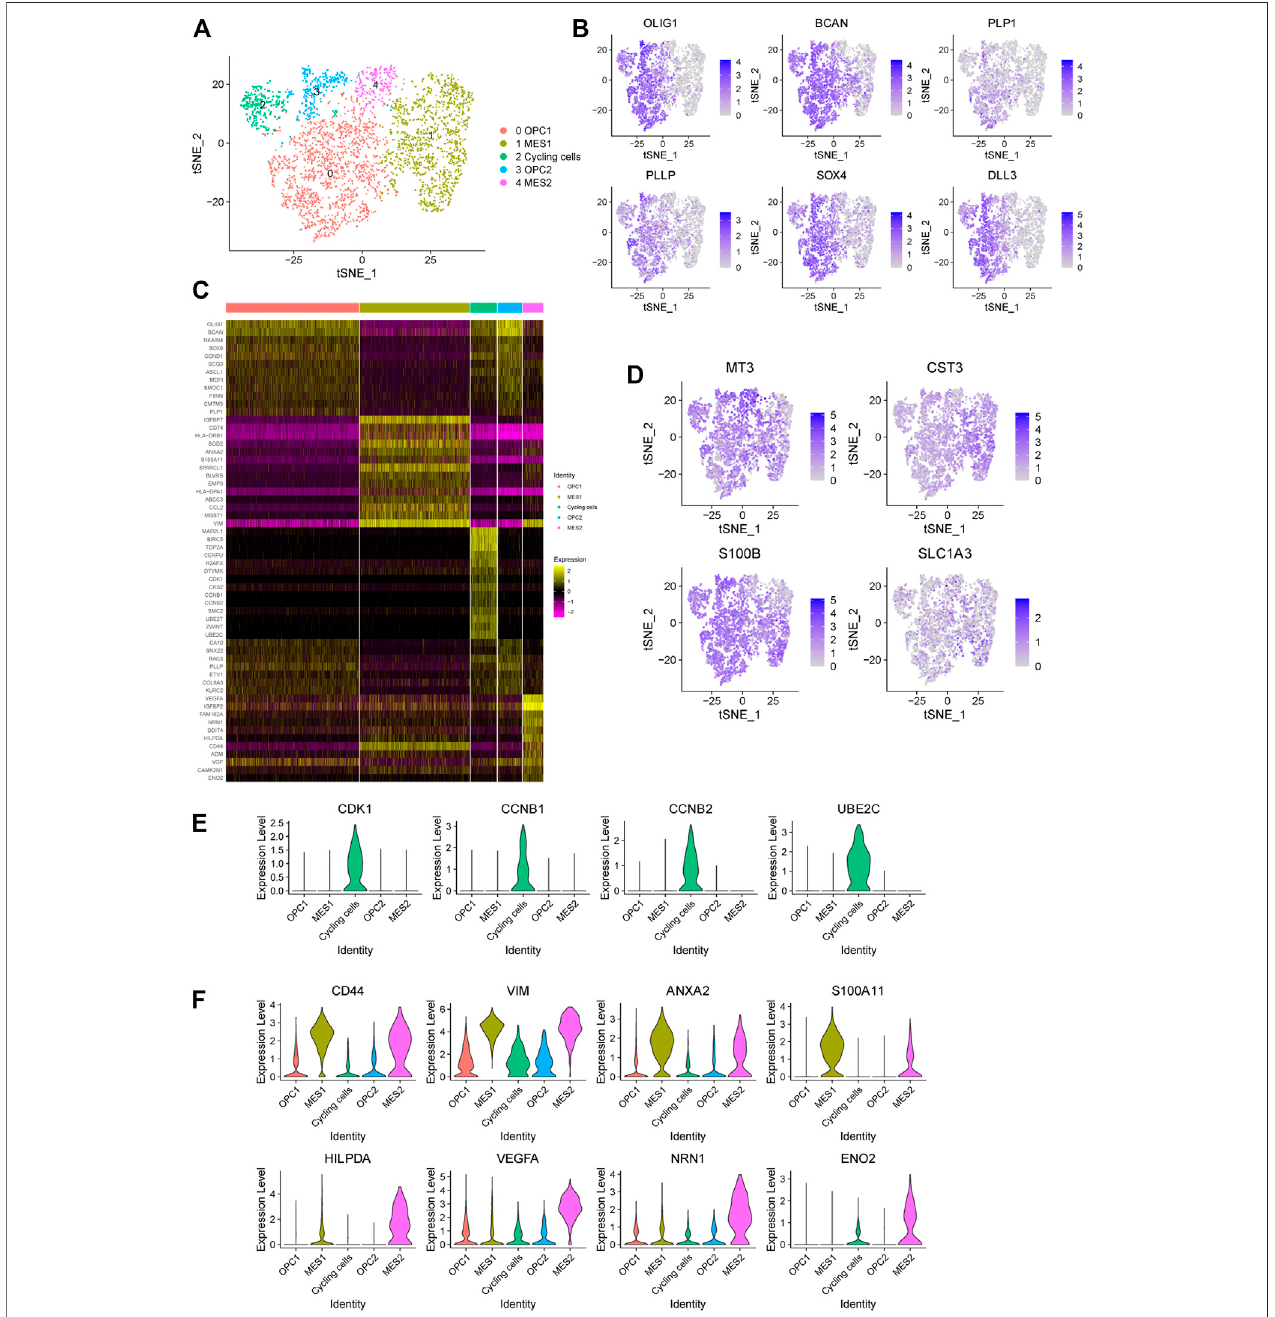
FIGURE3| Identi fi cationof fi vecancercellsubpopulations inaglioma. (A) Thet-SNEplotshowing3,834cancercellscoloredbysubtypes.OPC,oligodendrocyte progenitor-like (OPC-like); MES, mesenchymal-like (MES-like). (B) The t-SNE plot showing the expression levels of representative markers of OPC-like cells (OLIG1, BCAN,PLP1andPLLP)andNPC-likecells(SOX4andDLL3)inindividualcells. (C) Heatmap displayingthetopregulatedgenesineachcellclustercomparedtoallother clusters according to the average Log2 (fold change). (D) The t-SNE plot showing the expression levels of representative markers of AC-like cells (MT3, CST3, S100BandSLC1A3)inindividualcells. (E) Theviolinplotshowingtheexpressionlevelsofrepresentativemarkersofcyclingcells(CDK1,CCNB1,CCNB2andUBE2C)in each cluster. (F) The violin plot showing the expression levels of representative markers of MES1 cells (CD44, VIM, ANXA2 and S100A11) and MES2 cells (HILPDA, VEGFA, NRN1 and ENO2) in each cluster.